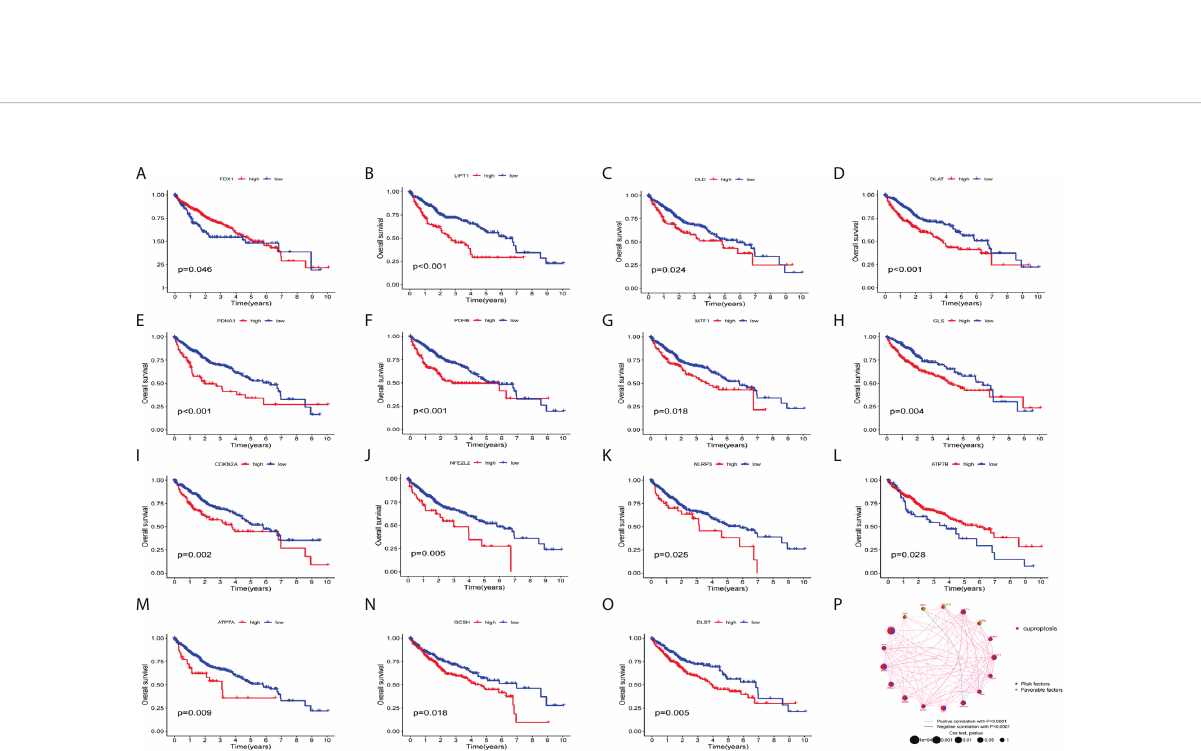
FIGURE 3 Prognosis signi fi cance of CRGs of HCC patients in TCGA and GEO in HCC. (A – O) K-M survival curve displays the OS of HCC patients. (P) Prognostic network of